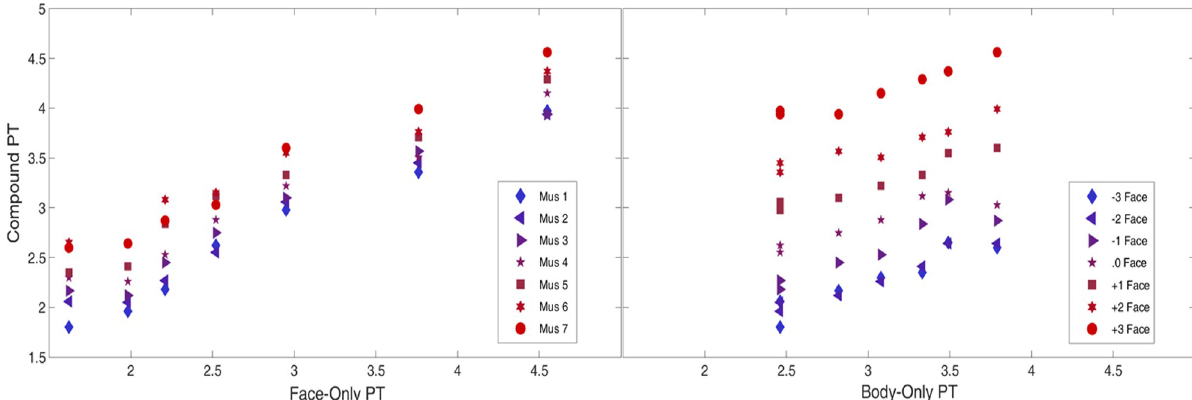
Fig 4. Scatterplots outlining the relationship between the perceived threat (PT) in the face-only stimuli and the compound stimuli (left) and between the perceived threat in the body-only stimuli and the compound stimuli (right). Each vertical cluster of data point corresponds to perceived threat of one level of face-only stimuli (left) or body-only stimuli (right).